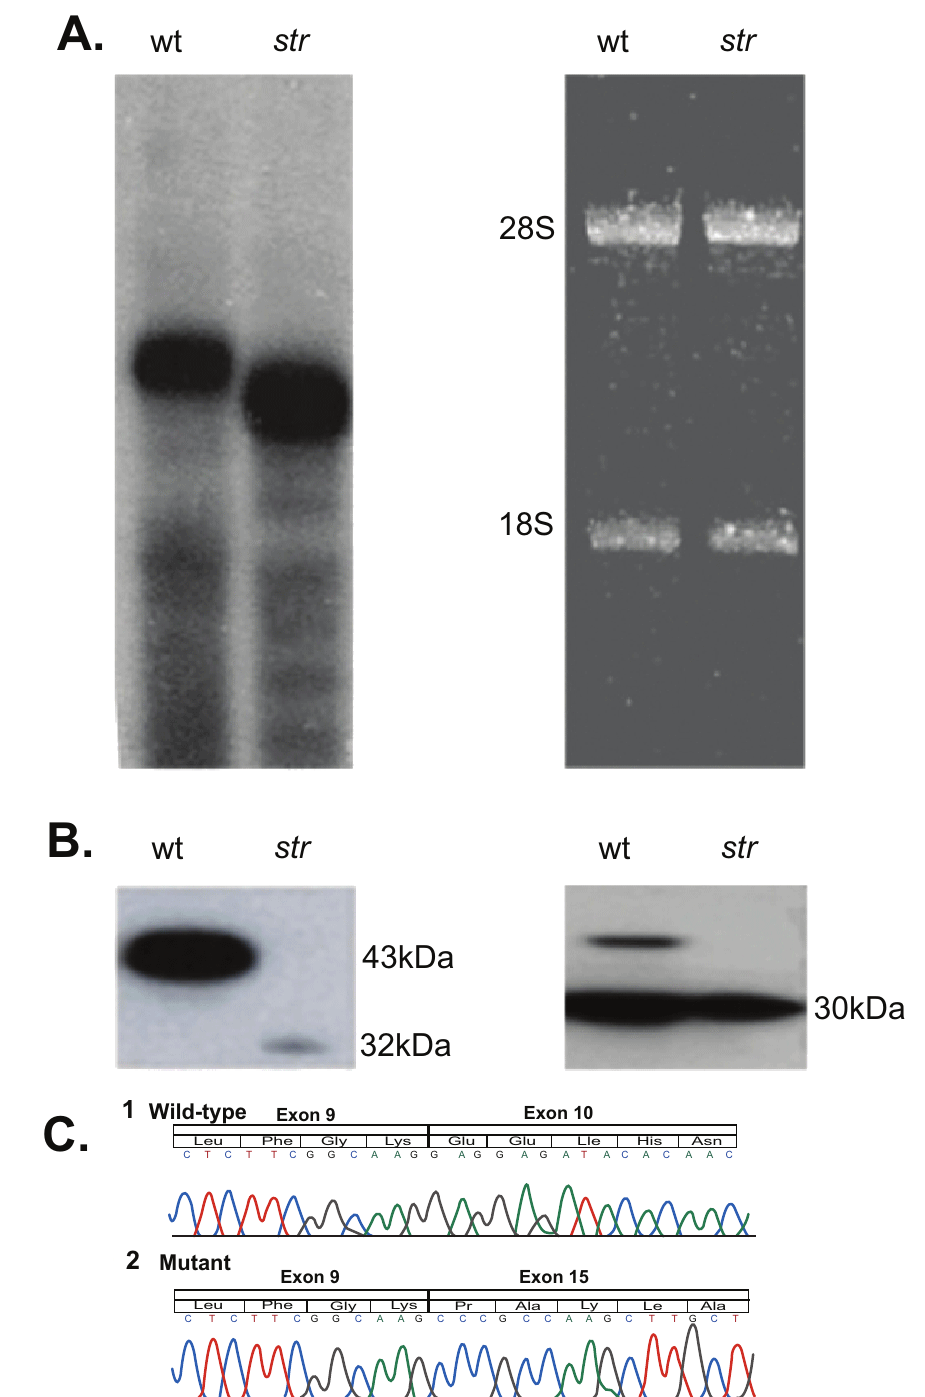
Figure 5. Analysis of Ndrg1 str transcripts and protein product. A . A northern blot of RNA from kidneys of wild-type and str mice. A 233bp probe spanning exons 2–4 detected in the mutant mouse anRNA species shorter than that seen in the wild-type Ndrg1 RNA ( left panel ). Ethidium bromide-staining of the agarose gel prior to northern transfer showed equal amounts of RNA were loaded ( right panel ). B . Western blot of sciatic nerve lysates prepared from wild-type and str mutant mice, probed with antibodies raised against the full-length Ndrg1 protein ( left ) or GAPDH ( right ). The full length (43 kDa) Ndrg1 protein was absent from the lysate of the str mice but an immunoreactive truncated (32 kDa) protein was present in a lower amount; this size is approximately that predicted for the Ndrg1 str mutant protein. C . Chromatograms and translated protein sequences of Ndrg1 cDNA prepared from kidney tissue from 1) wildtype BALB/C and 2) the mutant mouse. The deletion results in the skipping of exons 10–14. Exon 15 is spliced in-frame with exon